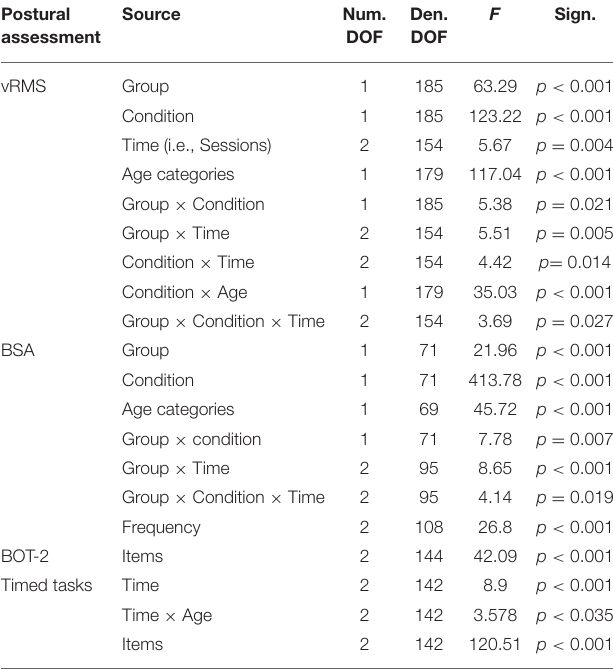
TABLE 2 | Statistical values of significant results in all postural